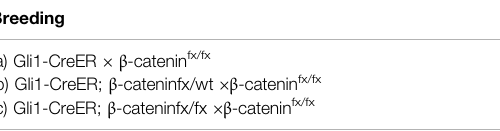
TABLE 3 | Breeding of Gli1-CreER; β -catenin fx/fx mice. Breeding Desired progeny